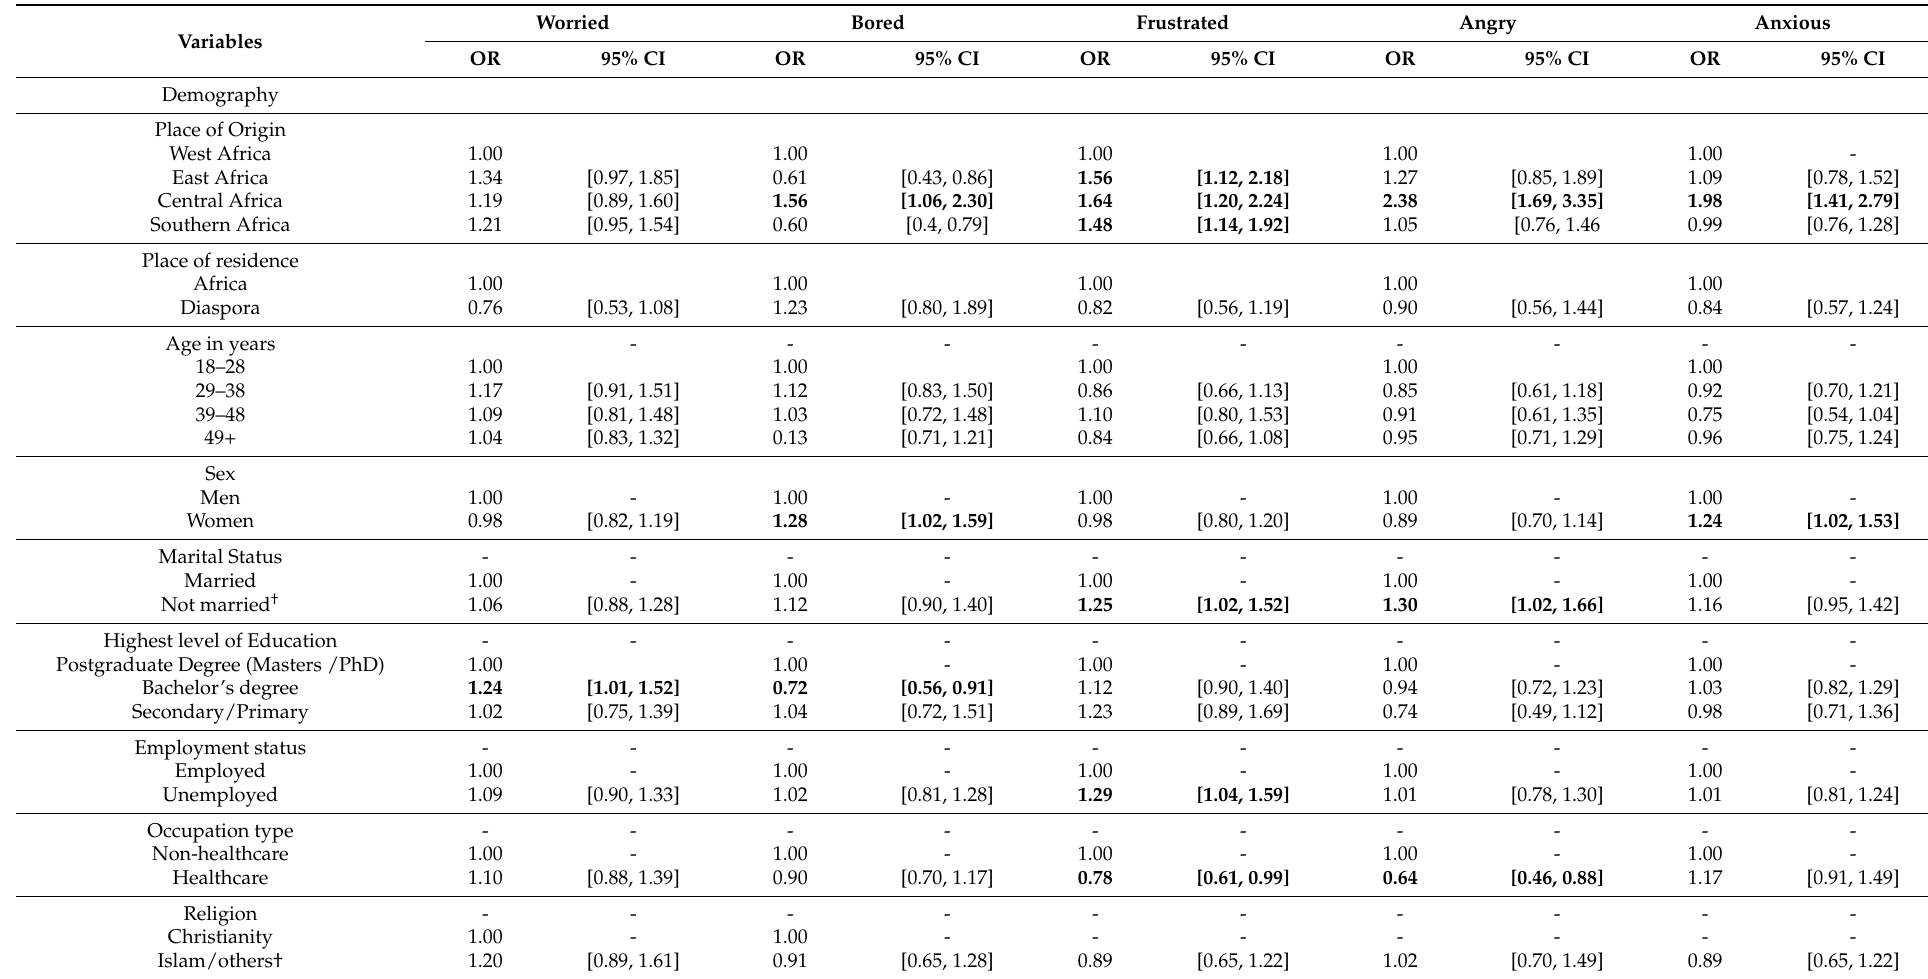
Table 2. Univariate analysis of factors associated with five mental health/emotional symptoms of COVID-19 among Sub-Sahara Africans during the lockdown. Worried Bored Frustrated Angry Anxious Variables OR 95% CI OR 95% CI OR 95% CI OR 95% CI OR 95% CI